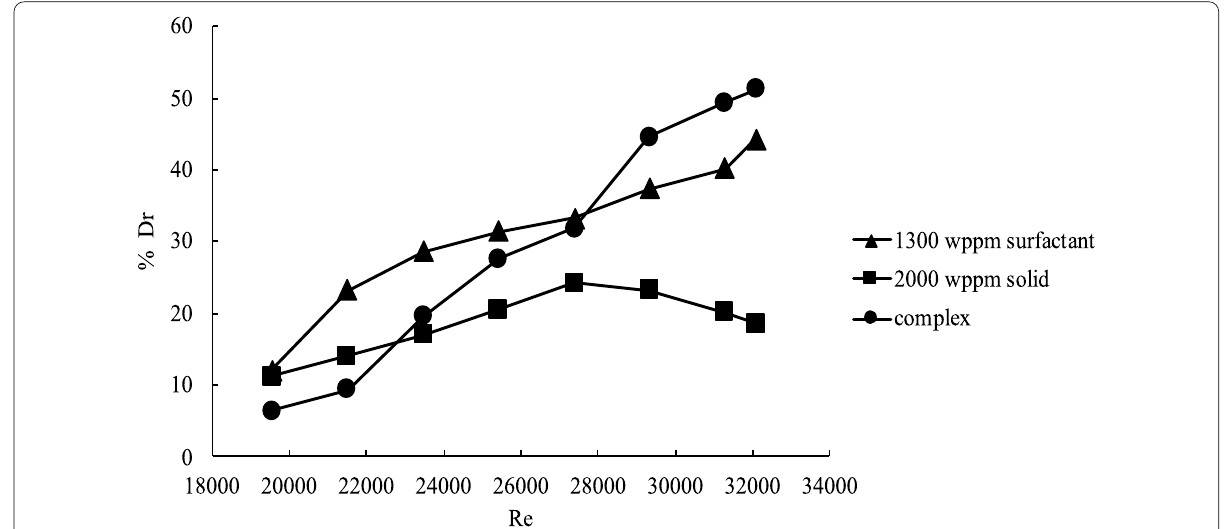
Fig. 10 Comparison between the 1300 wppm surfactant solution %Dr with the 2000 wppm solid suspension and their